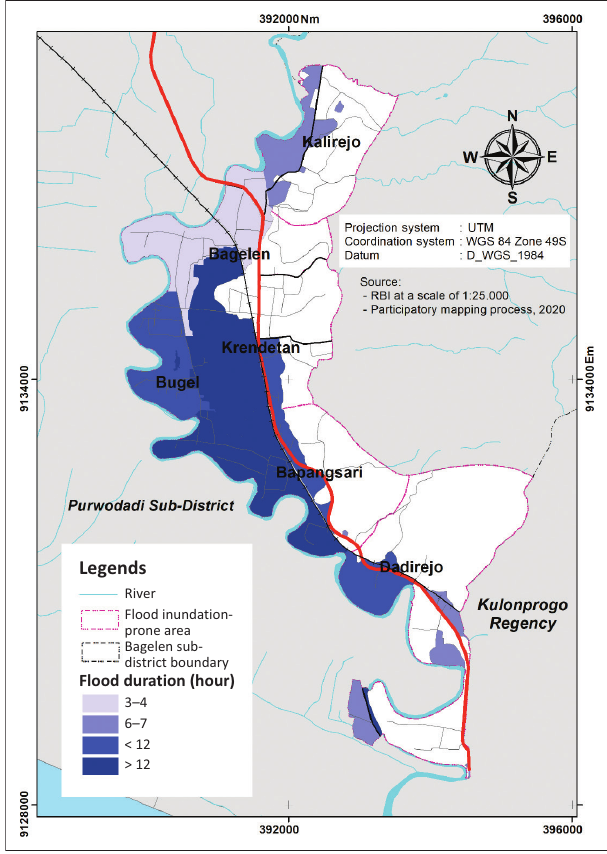
FIGURE 6: Flood duration